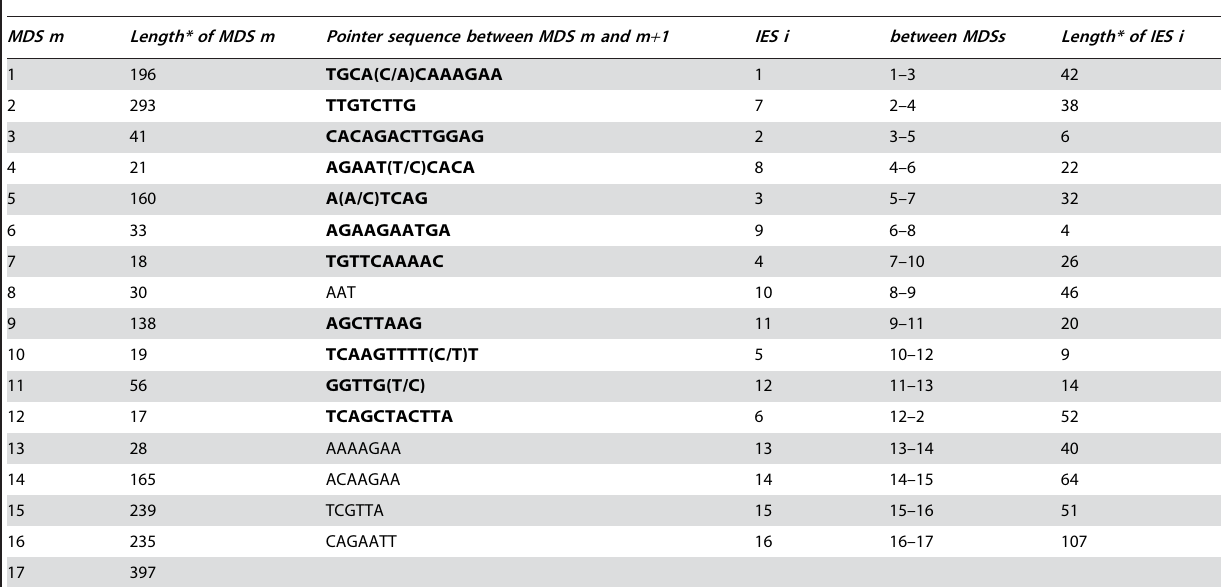
Table 3. Characteristics of MDSs, IESs, and pointers of the O. trifallax TEBP a gene.